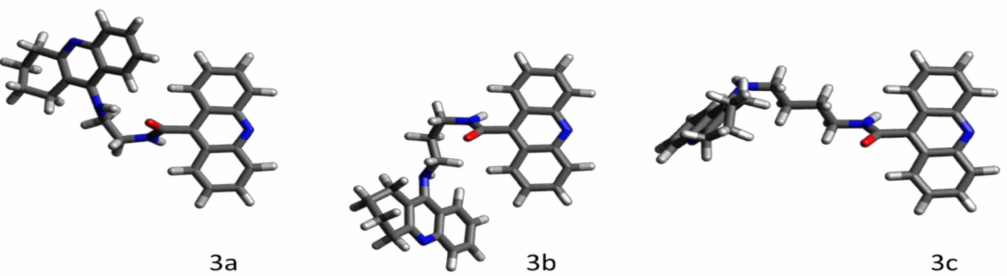
Figure 4. The thermally stable geometries of the smallest ligands in the studied series, calculated at the quantum-mechanical level of theory. Note that the bulky conformation of 3a is additionally stabilized by the intramolecular NH...O hydrogen bond. Both 3b and 3c exhibit hook-shaped